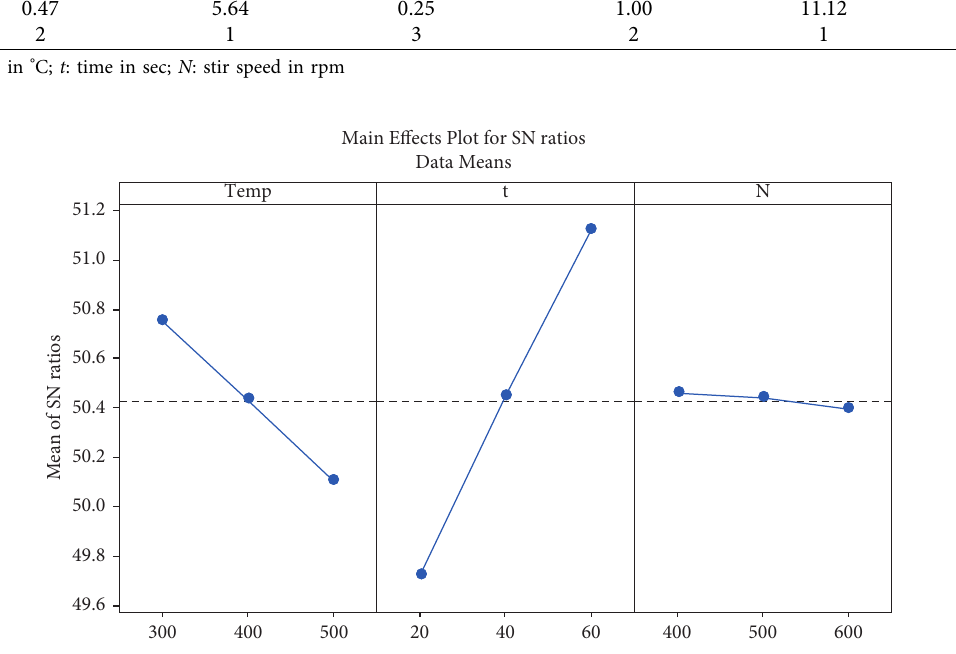
Figure 6: Significant consequence diagram based on the SN ratio for compressive strength (temp: temperature in ° C; t : time in sec; N : stir speed in rpm).